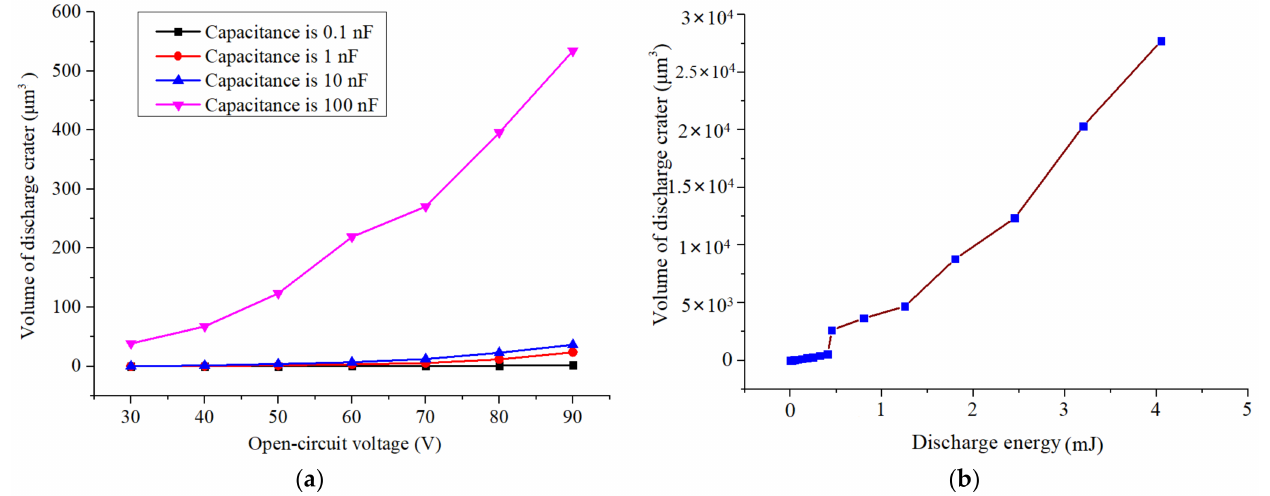
Figure 6. Effect of open-circuit voltage ( a ) and discharge energy ( b ) on discharge crater